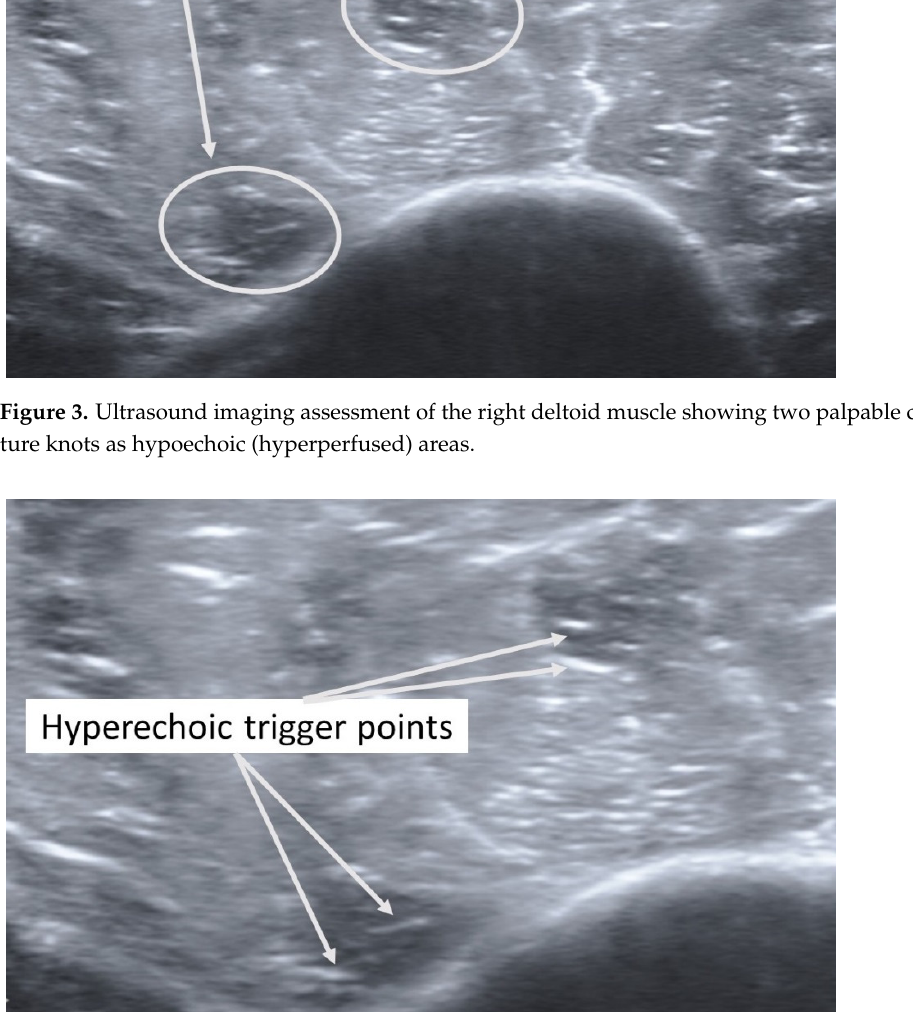
Figure 4. Detailed ultrasound imaging assessment of the right deltoid muscle showing a collection of small hyperechoic (hypoperfused) “TrP speckles” within each of the contracture knots .